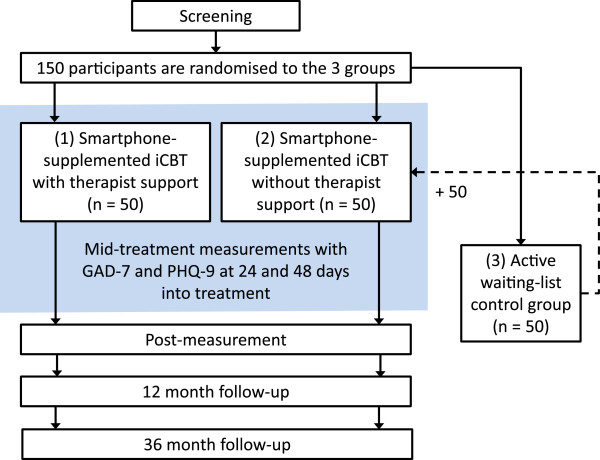
Study flowchart.